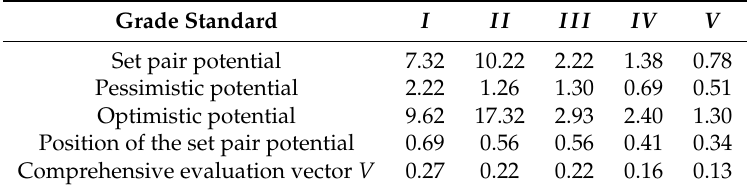
Table 5. Set pair analysis (SPA) comprehensive evaluation results of Jinan water resource assets (2015).